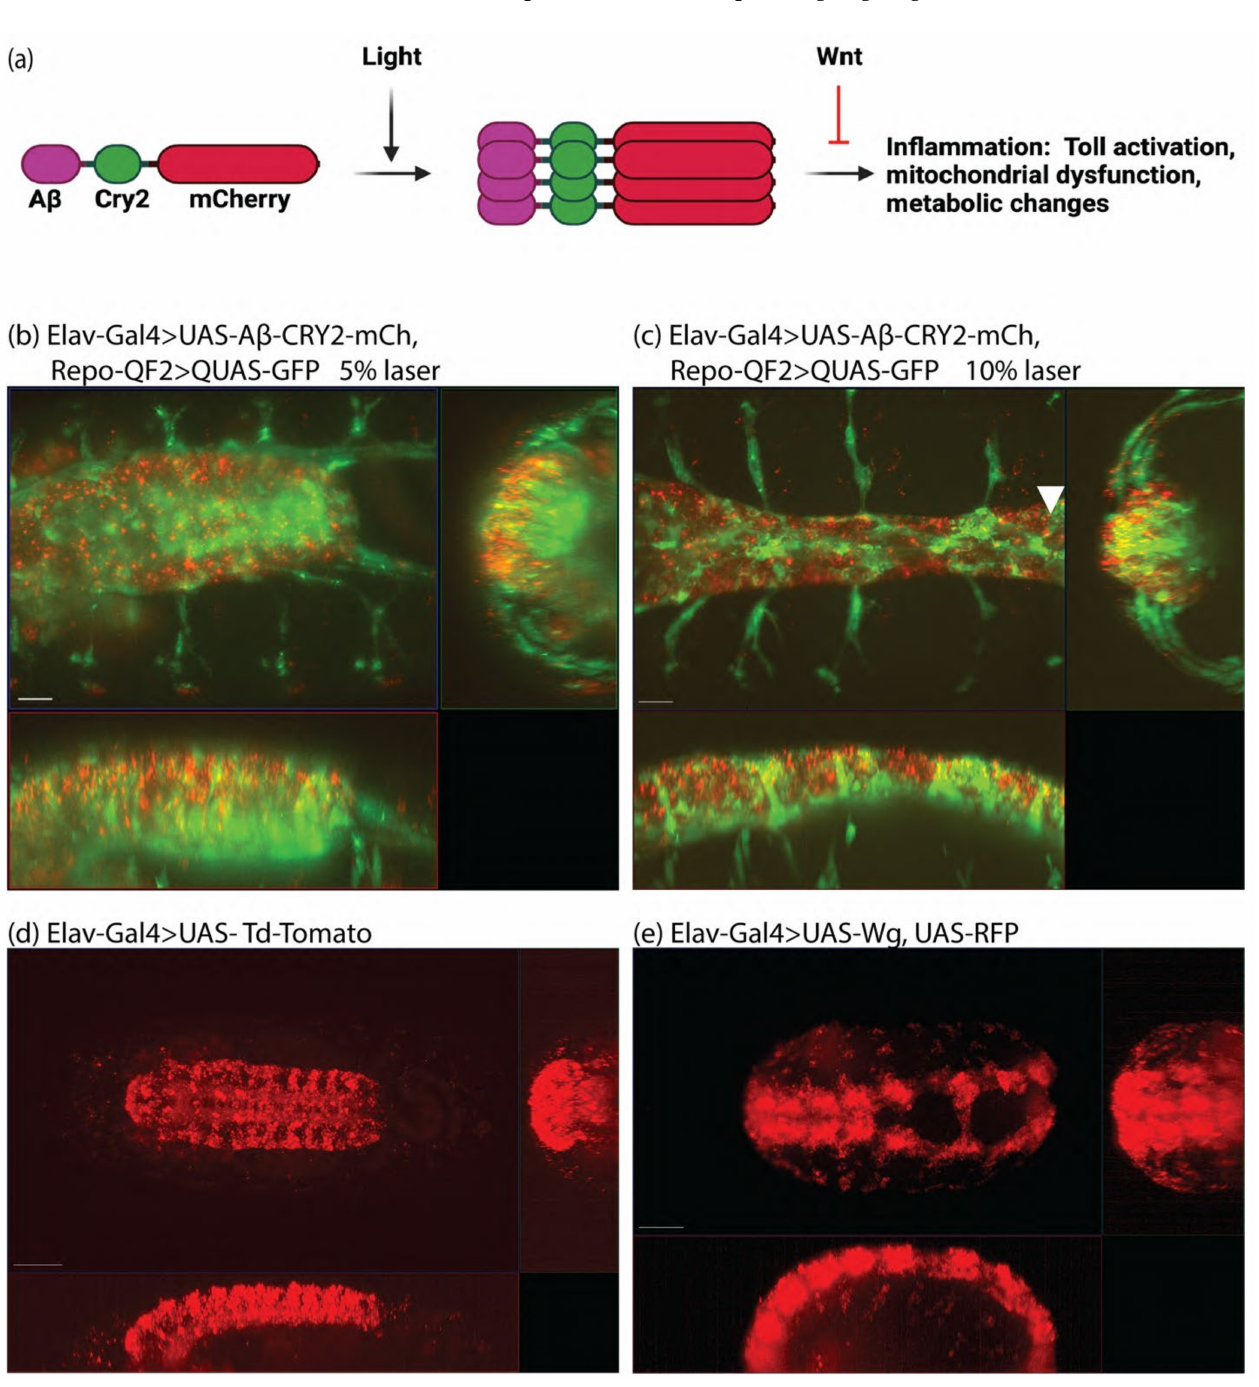
Figure 1. The optogenetic amyloid system in embryos. ( a ) Scheme of light-induced A β -Cry2mCh clustering in Drosophila melanogaster resulting in activation of inflammatory processes which can be rescued by Wnt. Stills from Video S1 ( b ), Video S2 ( c ), Video S3 ( d ), Video S4 ( e ). Arrowhead is pointing to nervous system